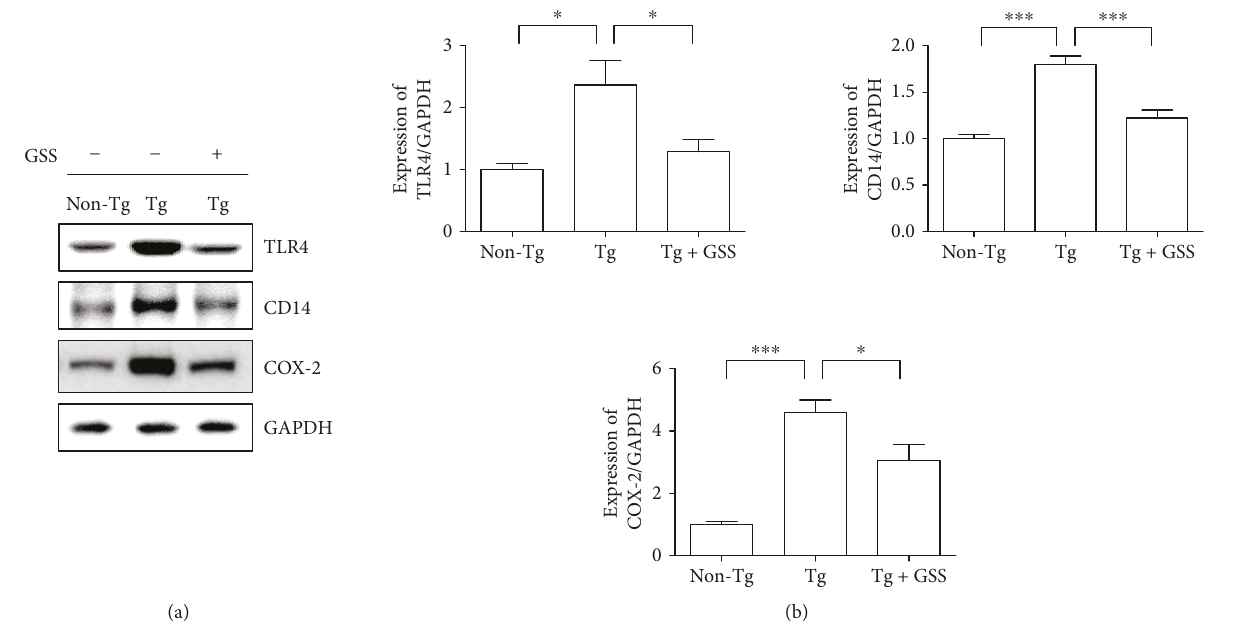
Figure 2: GSS administration downregulates TLR4 signaling-related proteins in the spinal cord of hSOD1 G93A transgenic mice. (a) Representative Western blot images displaying the protein levels of TLR4, CD14, and COX2 in the spinal cord of control (Non-Tg), hSOD1 G93A transgenic (Tg), and Tg mice treated with GSS (Tg+ GSS). GAPDH was used as a loading control. (b) Quantitative analysis of the normalized levels of TLR4, CD14, and COX2 over GAPDH. The data shown are the means ± SEM ( n = 4 ) and were evaluated by one- way ANOVA and Newman-Keuls ’ post hoc test. ∗ p < 0 05 and ∗∗∗ p < 0 001